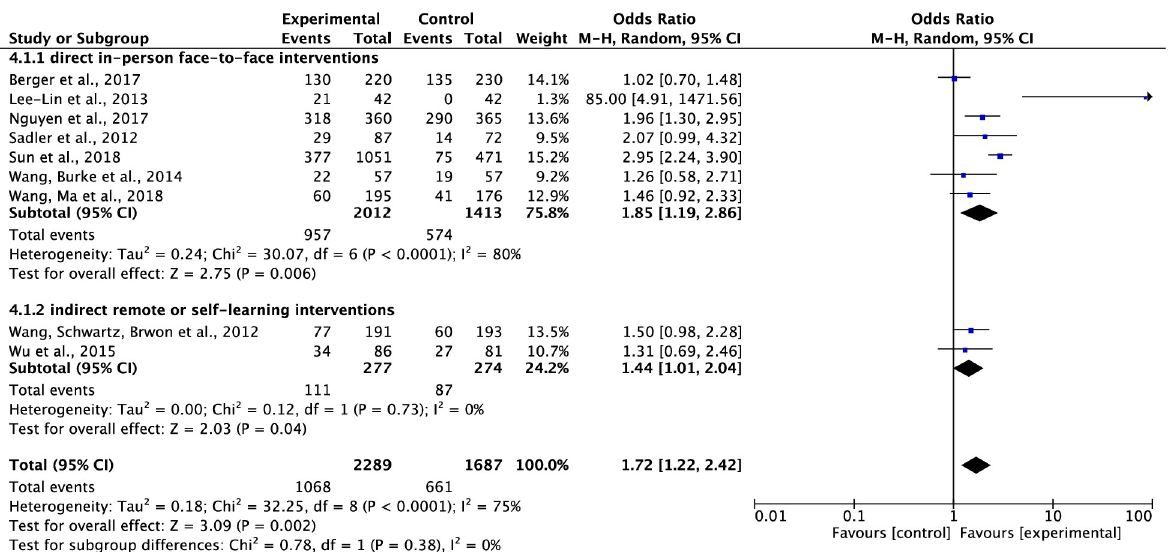
Fig 7. Forest plot of direct in-person face-to-face VS. indirect remote or self-learning interventions on participants’ completion of cancer screening.